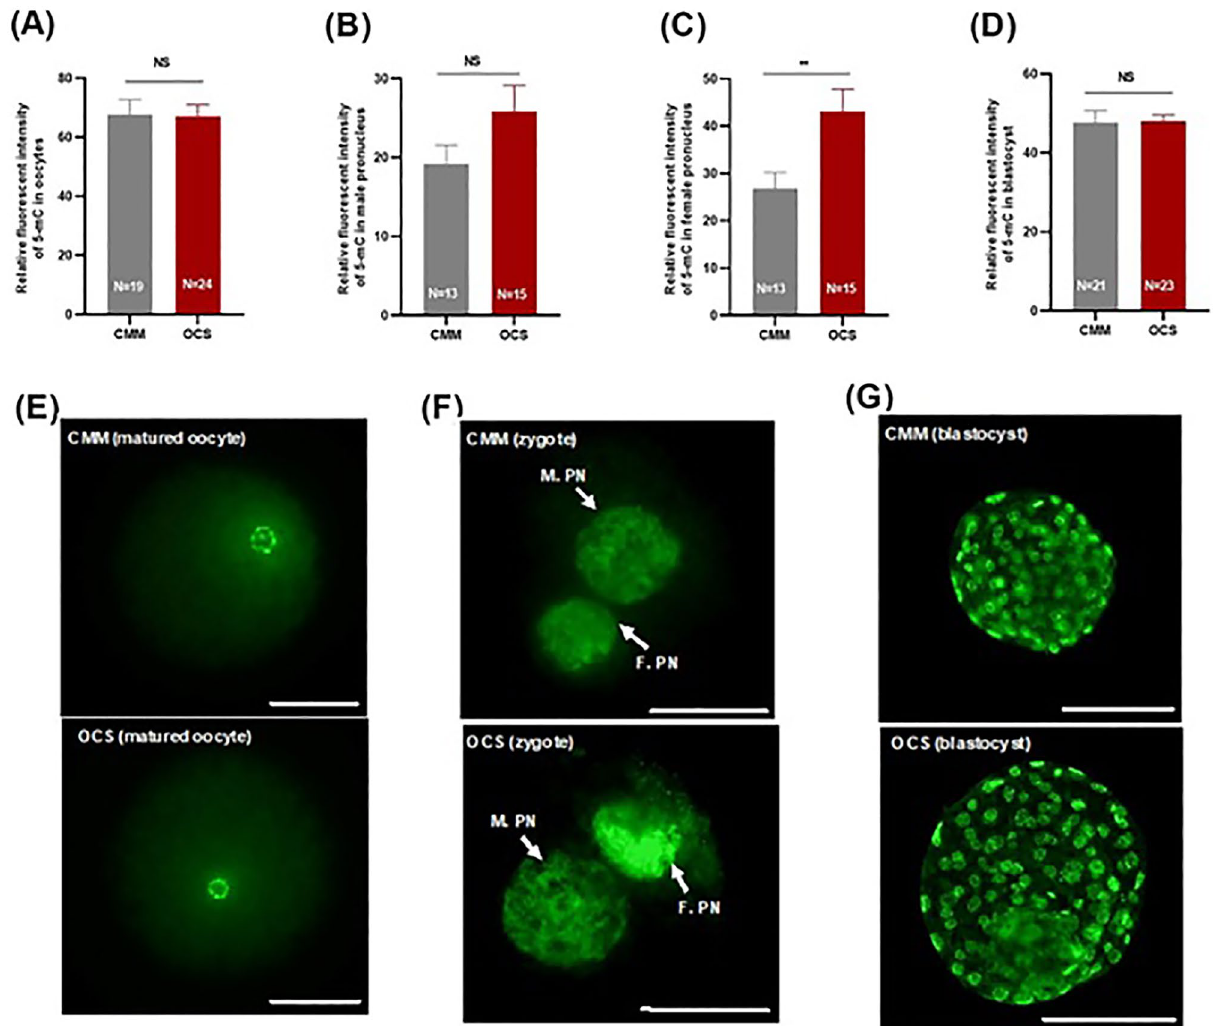
Figure 6. Effect of one carbon supplementation on global DNA methylation level of matured oocytes, zygotes and blastocysts. Relative fluorescent intensity of 5mC in ( A ) matured oocytes, ( B ) male and ( C ) female pronucleus of zygotes and ( D ) blastocysts. Representative images of 5-mC immunocytochemistry of ( E ) matured oocytes (40 × magnification; Scale bar, 50 µm), of ( F ) zygotes (40 × magnification; Scale bar, 50 µm) and of ( G ) blastocysts (20 × magnification; Scale bar, 100 µm). M.PN male pronucleus and F.PN female pronucleus. The data are shown as mean ± s.e.m. NS stands for non-significant differences ( P ˃ 0.05). **Stands for P ≤ 0.01. N stands for total number of oocytes, zygotes or blastocysts in each